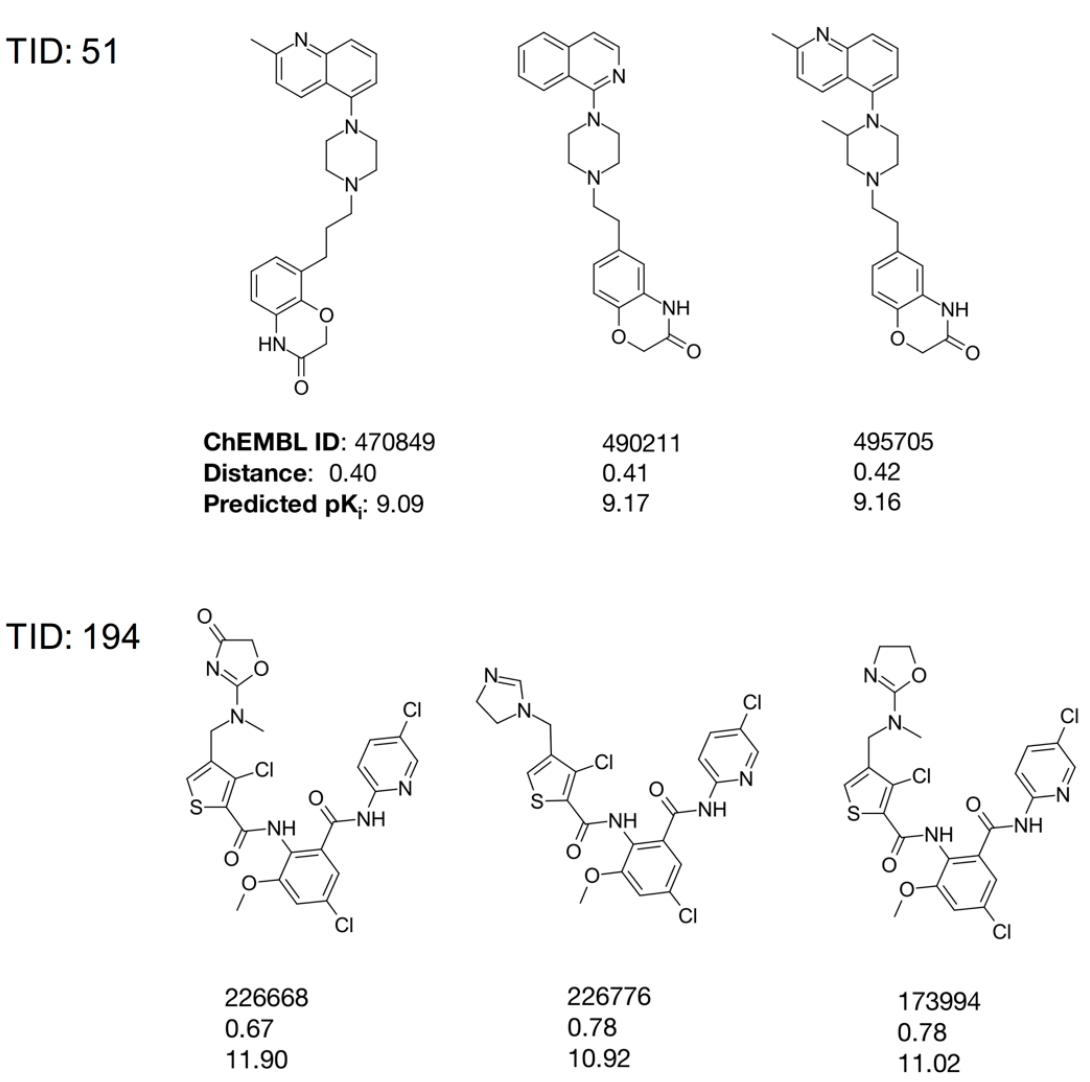
Figure 7. Nearest neighbors of optimized coordinates. For the two activity classes in Figure 5 and Figure 6, structures of the three nearest neighbors of optimized coordinates are shown and their ChEMBL IDs, scaled distances to the optimized coordinates and predicted pK values, are